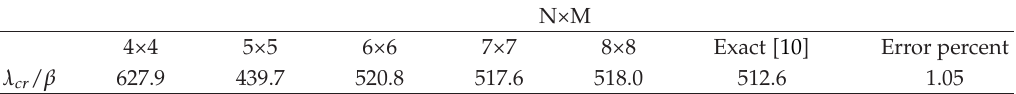
Table 1: Critical dynamic pressure predicted by the current analysis for di ff erent order of approximation series and comparison with the exact solution (cid:4) 10 (cid:5) .